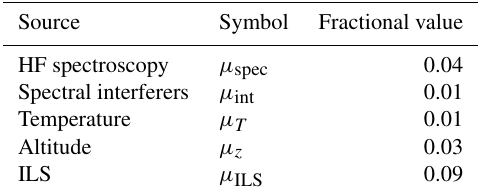
Table 3. Sources of systematic uncertainty in the ACE-FTS